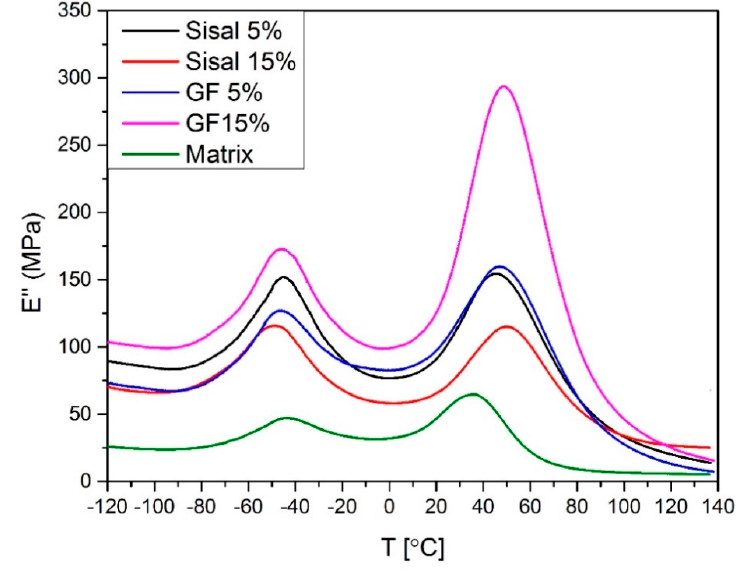
Figure 10. Loss modulus values of obtained hybrids.